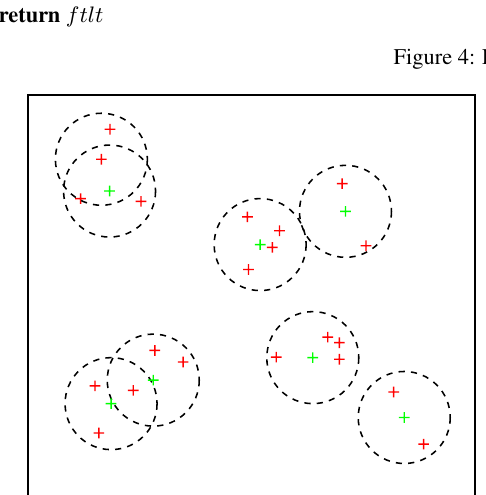
Figure 4: Feature reduction algorithm figuration file, which include various configuration